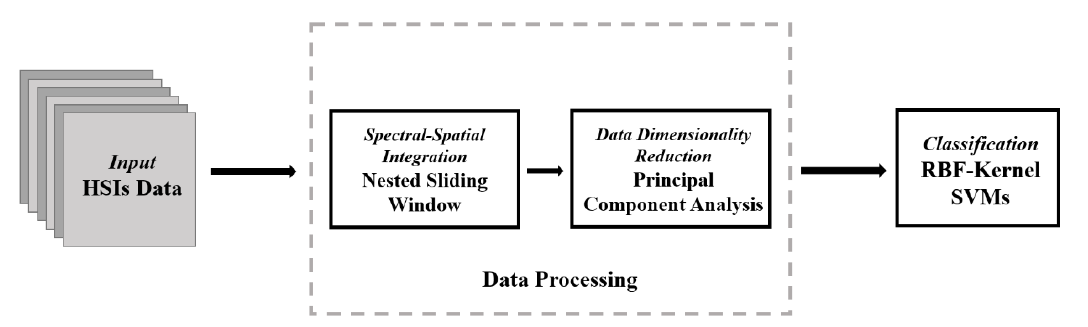
Figure 1. Structure of the proposed Nested Sliding Window (NSW)–Principal Component Analysis (PCA)–Support Vector Machine (SVM)